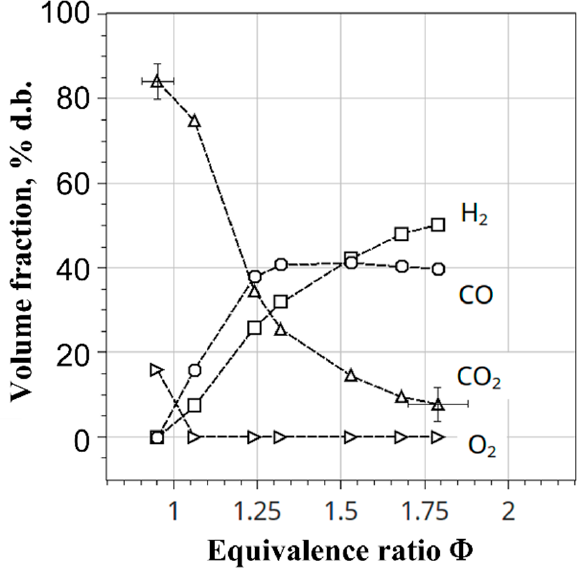
Figure 8. Measured composition of cooled dry detonation products of СН 4 / О 2 mixture vs. Ф ( (cid:1858) = 1 Hz, (cid:1842) (cid:3406) 0.1 MPa). Measurement errors are shown only for the limiting values of Φ .